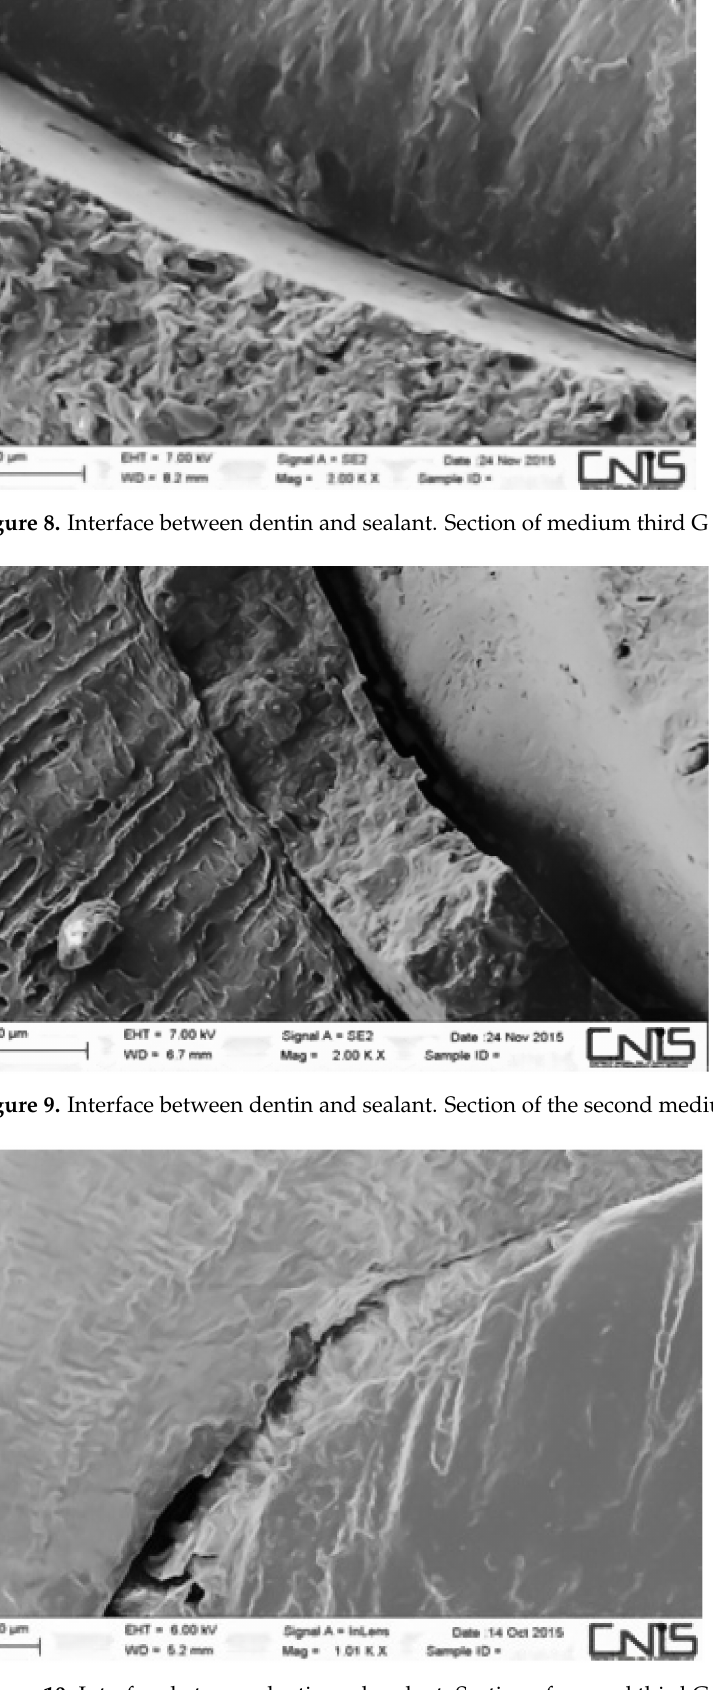
Figure 10. Interface between dentin and sealant. Section of coronal third G